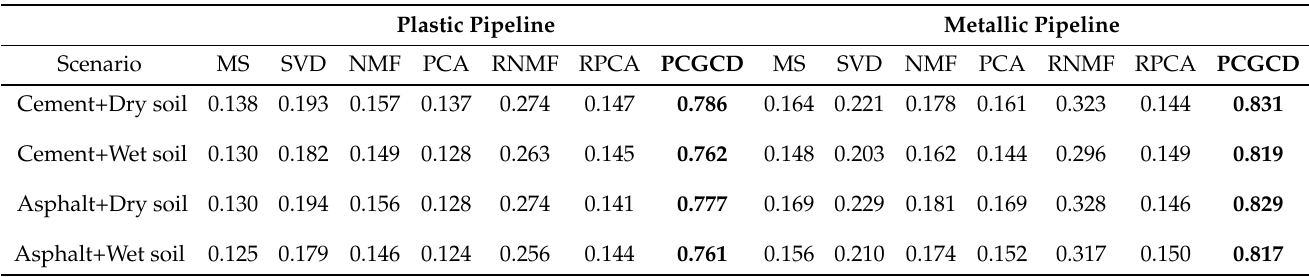
Table 3. SSIM results for the plastic and metallic pipelines buried in different scenarios.